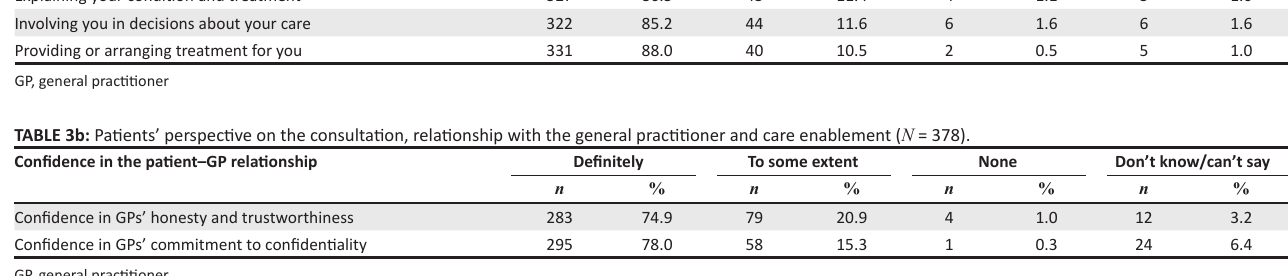
TABLE 3c: Patients’ perspective on the consultation, relationship with the general practitioner and care enablement ( N = 378). Care enablement – how well the GP enabled the patient to: Understand your health problems